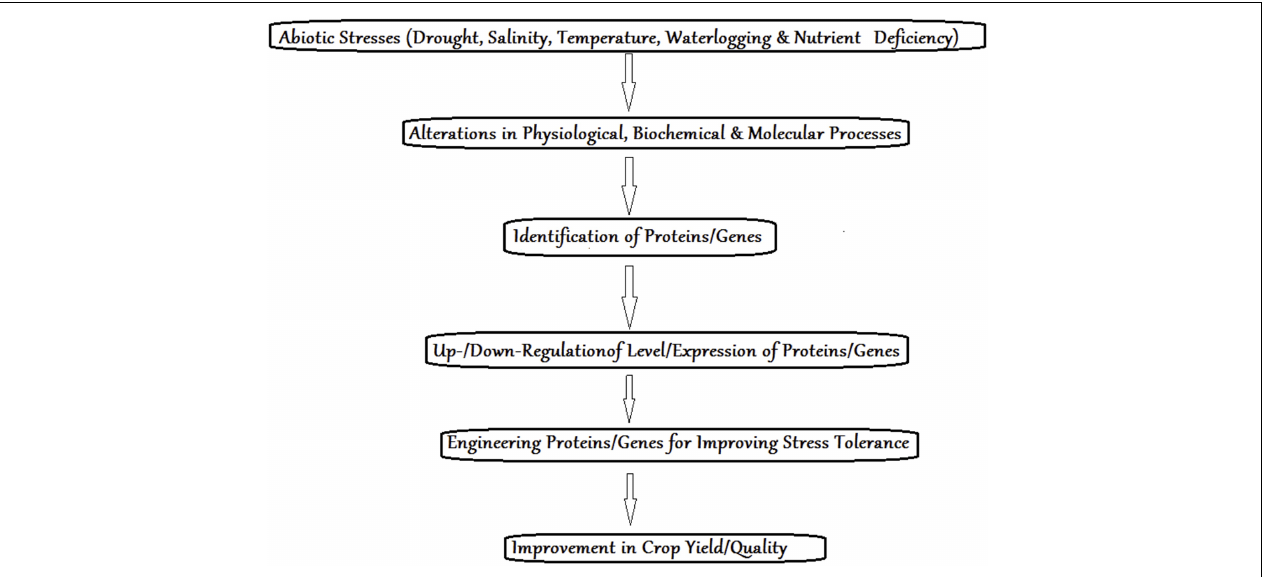
FIGURE 1 | Improvement in crop yield under stress conditions using proteomic